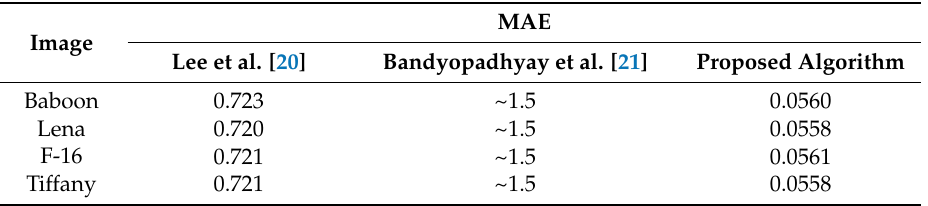
Table 2. Comparison of MAE values for some